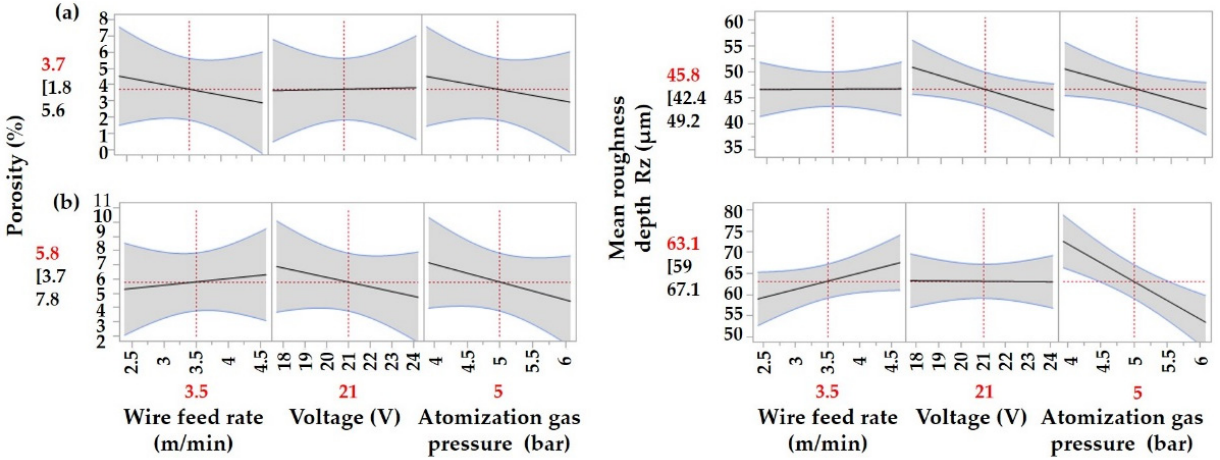
Figure 9. The effect of the process parameters on coating porosity and roughness ( a ) of compressed air sprayed coatings and ( b ) of argon sprayed coatings.